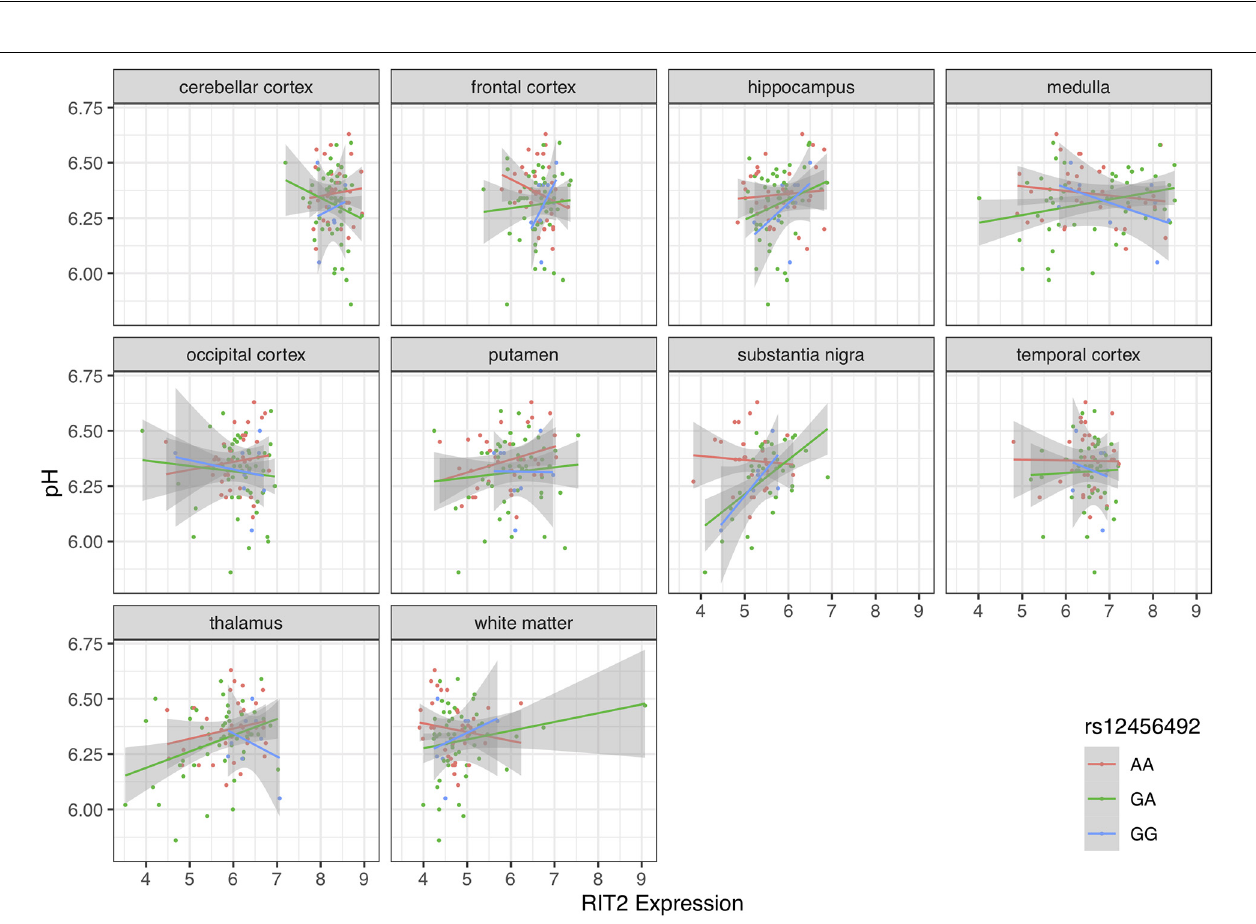
FIGURE 4 | Scatter plot of pH and RIT2 gene expression based on rs12456492 genotype for 10 brain regions. Genotype groups are colored with lines representing linear fits with shaded areas marking the 0.95 confidence intervals.